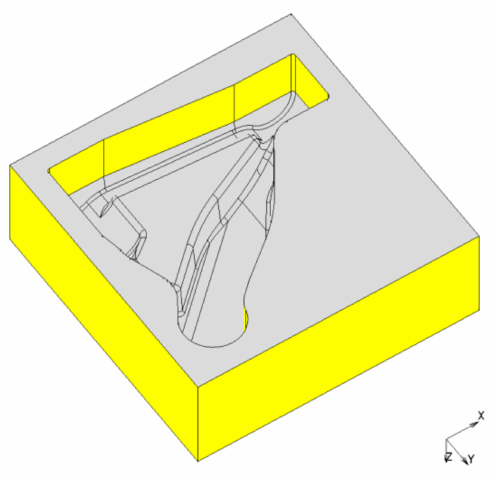
Figure 8. Forming